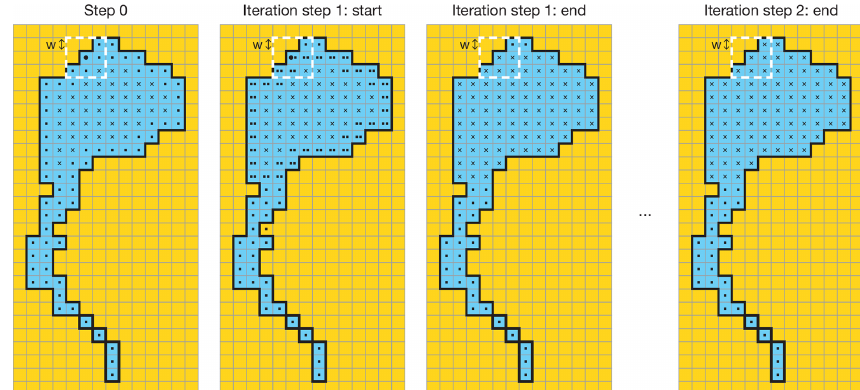
Figure 7. Steps of the pixel-by-pixel water separation algorithm. L – number of iterations (here L = 2); W – window width (here W = 1); · – water grid box has not only water points in its checking window; x – water grid box has only water points in its checking window; ·· – water grid box has at least one x in its checking window; yellow colour indicates land, and dark blue indicates water. Table 1. List of geographical locations for the water pixel-by-pixel separation algorithm application. Region North South West